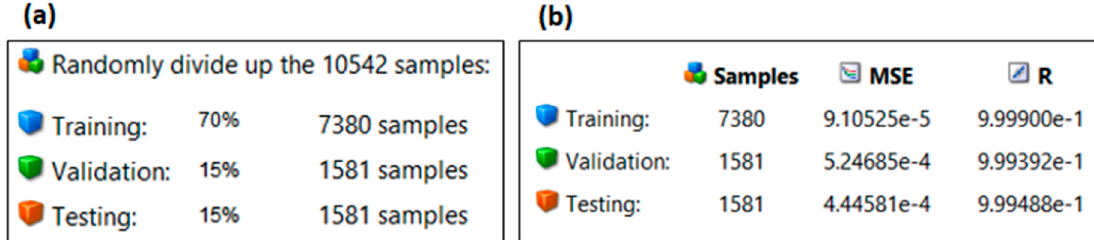
Figure 11. Training data division and single neural network training results: ( a ) training, validation and test samples, ( b ) mean squared error and the level of regression values.